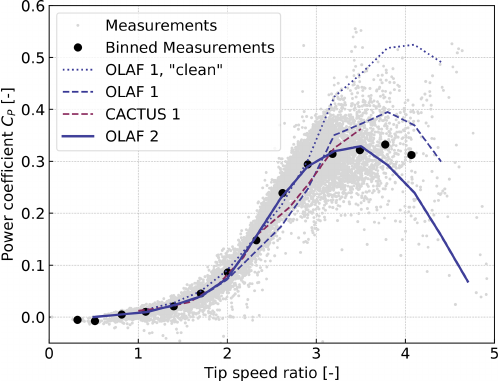
Figure 10. Performance of the VAWT model as obtained with the simulation tools OLAF and CACTUS, compared with measure- ments for two sets of inputs (one tuned for CACTUS, another tuned for OLAF). The curve “OLAF 1, clean” does not include excres-